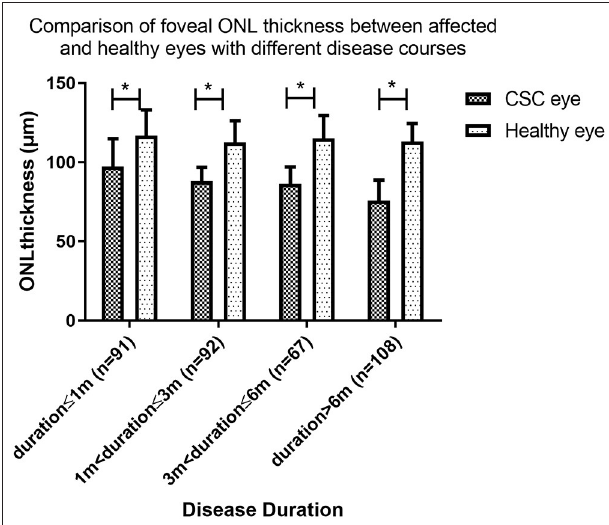
FIGURE 2 | Comparison of foveal outer nuclear layer (ONL) thickness between affected and healthy eyes with different disease courses. The foveal ONL thickness of the affected eye is significantly thinner in all groups (paired t -test, P = 0.004, P < 0.001, P < 0.001, P < 0.001). (* indicates statistical significance). CSC, central serous chorioretinopathy.